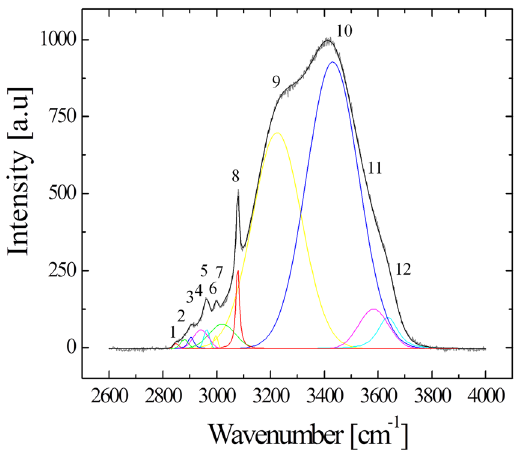
Figure 5. Typical Raman spectrum obtained from A6 cells, focusing the laser probe close to the polycarbonate substrate. Assignments of the labeled bands are reported in Table 2.